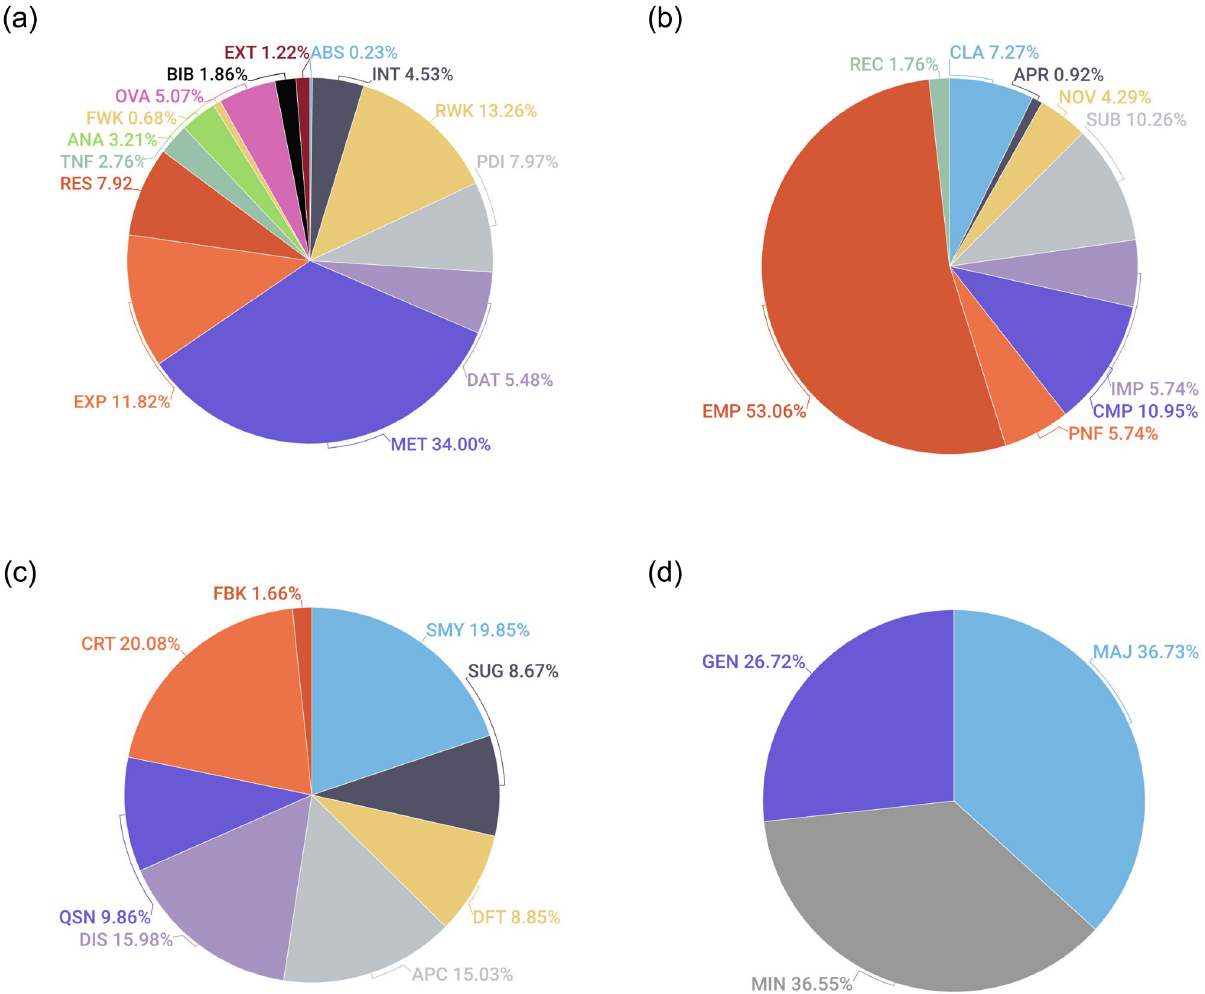
Fig 2. Label distribution pie charts showing the relative importance of each category of statements in one single review across the four layers. The average label occurrence for each layer in Table 4 is translated to percentage distribution in these pie charts. (a) Layer 1. (b) Layer 2. (c) Layer 3. (d) Layer